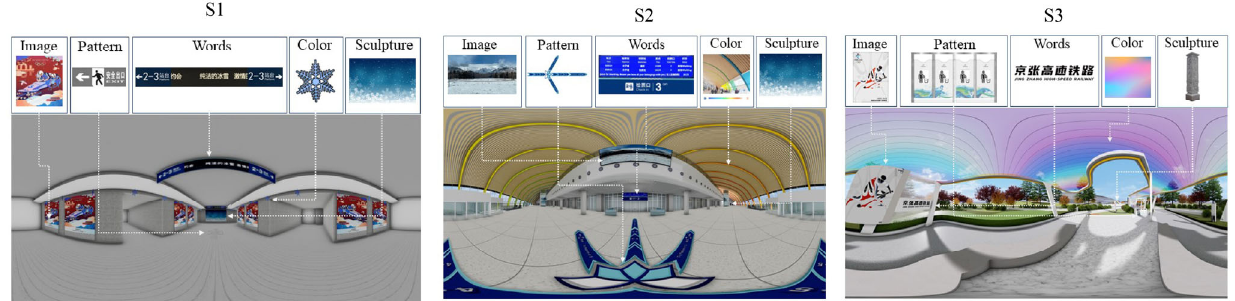
Figure 7. S1–S3 layout schematic.